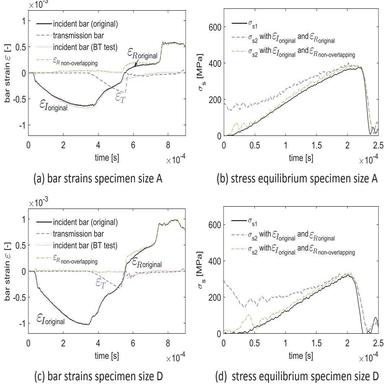
Bar strain wave group of a SHPB DENC test, and dynamic stress equilibrium check for specimens of sizes A (a and b) and D (c and d).